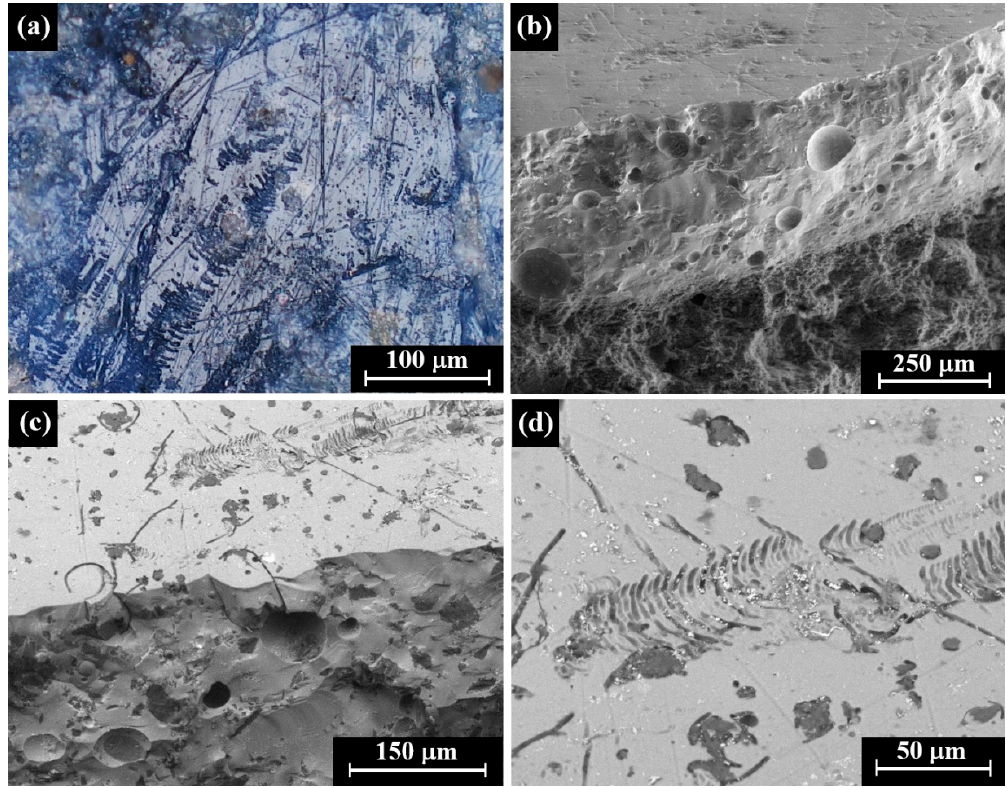
Figure 9. Tile no. 334 (Type A): ( a ) creep deformation and chatter mark trails (multifocal LM); ( b ) the clay base covered with white glaze which includes gas bubbles (SEM, SE); ( c ) creep deformation and chatter mark trails in the white glaze coating [back-scattered electrons (BSE) mode]; and ( d ) higher magnification of Figure 9c.